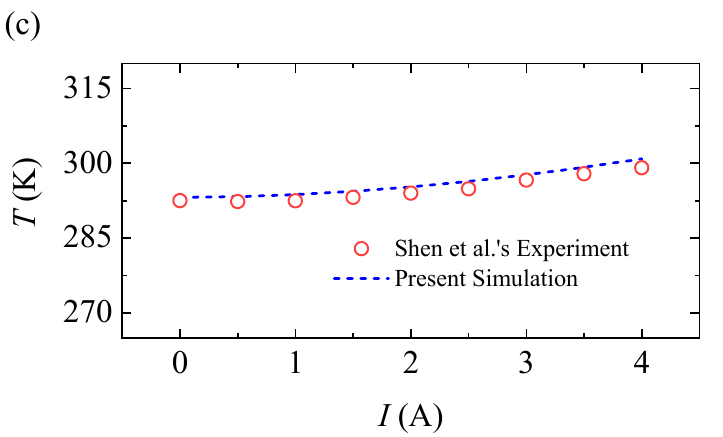
Figure 3. Model validation: ( a ) I - U relationship compared with Ref. [31]; ( b ) I - U relationship compared with Ref. [32]; ( c ) Temperature of the hot side end compared with Ref. [33].